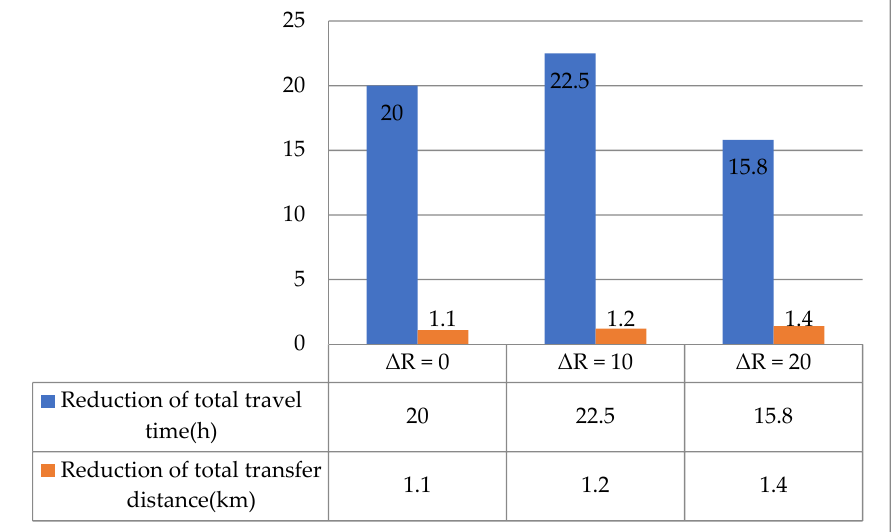
Figure 11. Comparative analysis of the conventional and proposed models for various factors.